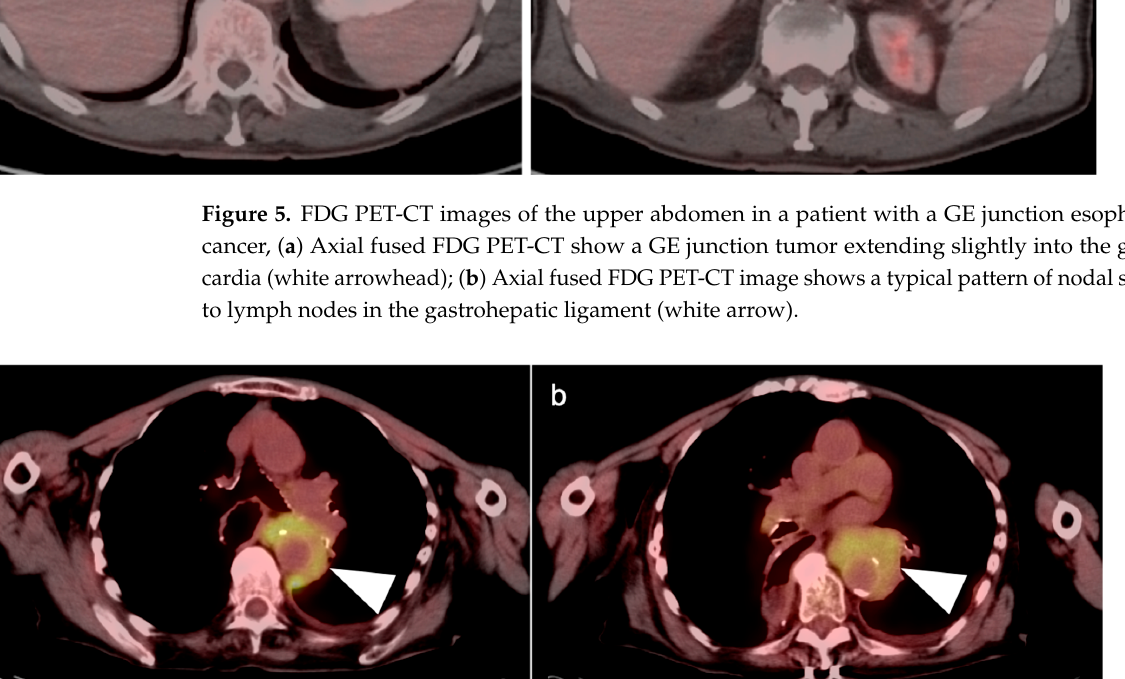
Figure 6. ( a , b ) Axial fused FDG PET-CT images of the chest show a recurrent mid-esophageal cancer